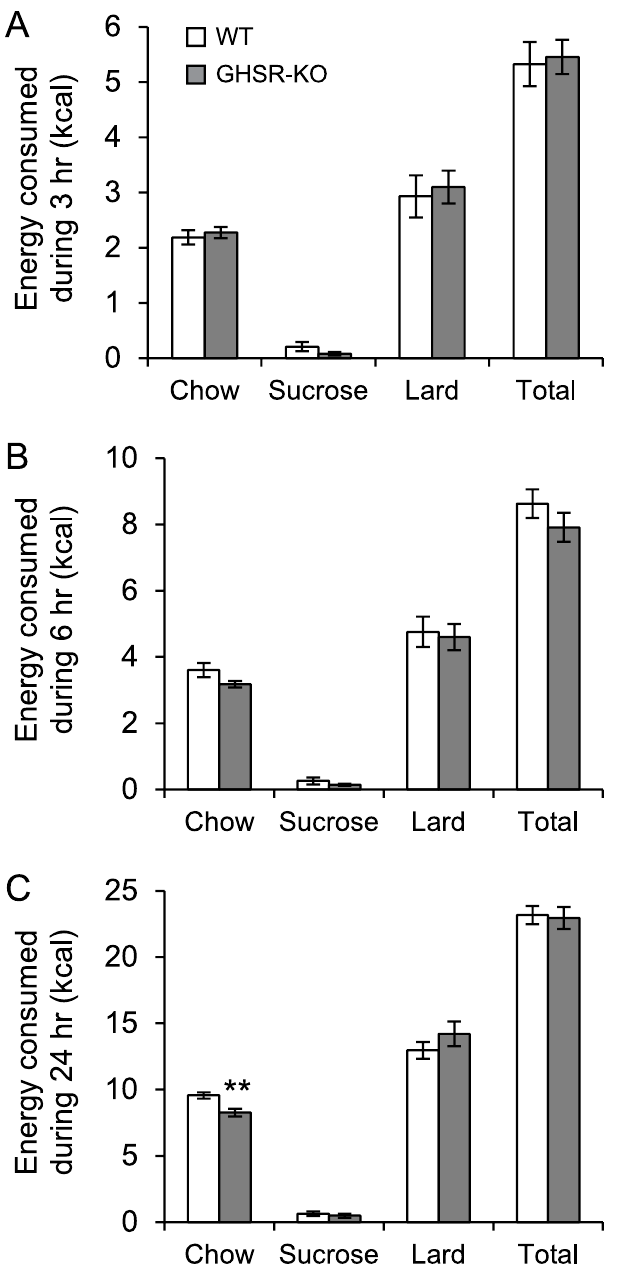
mice (GHSR-KO) and wild-type (WT) controls that had been ad libitum fed a choice diet comprising normal chow, 1 g sucrose pellets and lard (saturated animal fat) for 14 days prior to the overnight fast. ** P < 0.01 (one-way